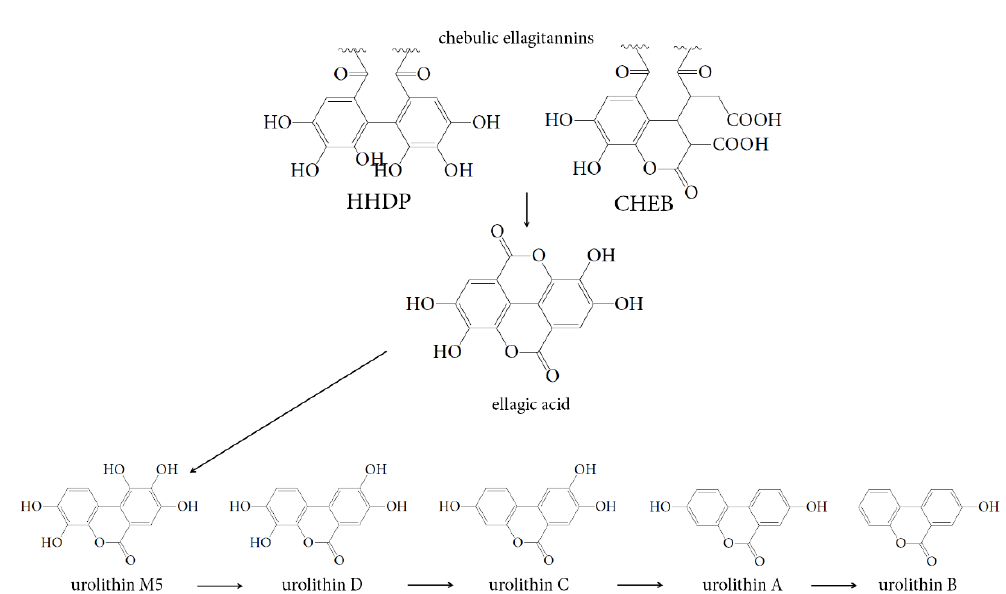
Figure 10. Proposed pathway of chebulic ellagitannins transformation by intestinal bacteria. HHDP— hexahydrodiphenoyl moiety, CHEB—chebuloyl moiety.